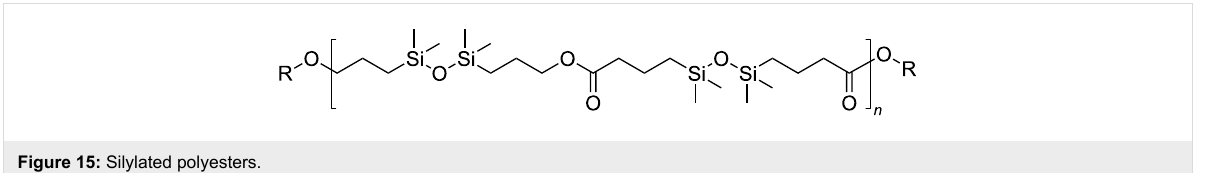
Figure 14: Curcumin-based polyesters.